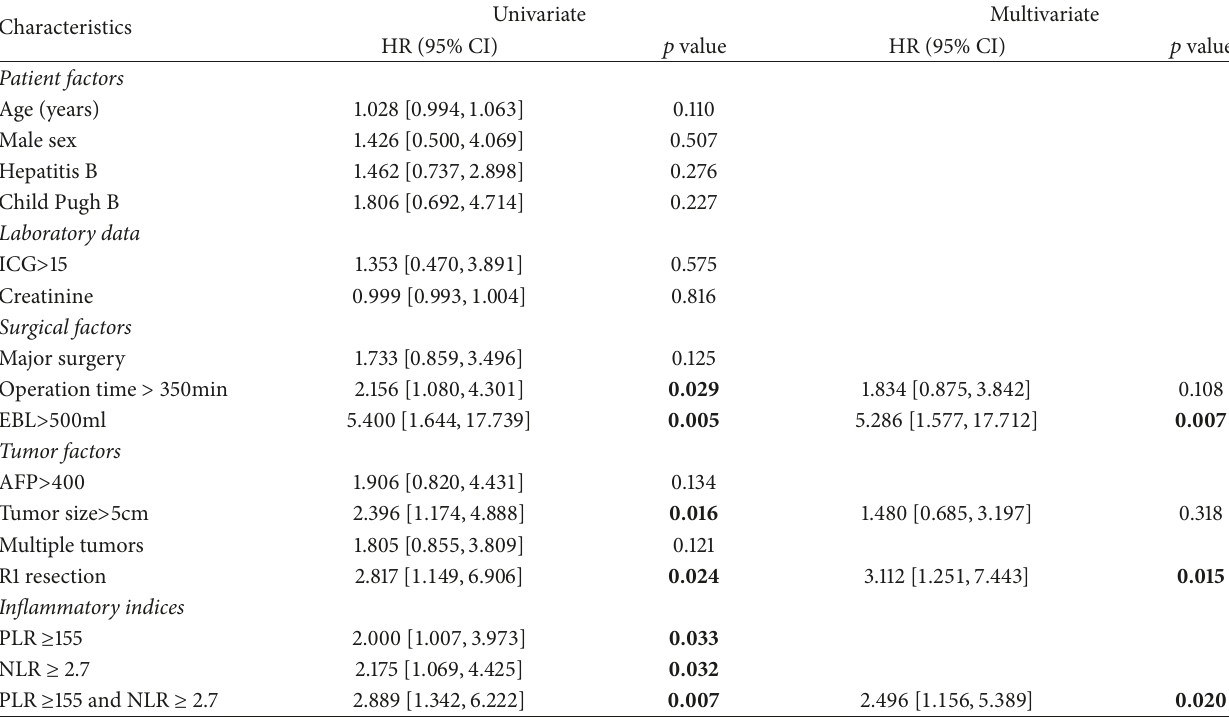
Table 2: Univariate and multivariate analysis of prognostic factors for overall survival.